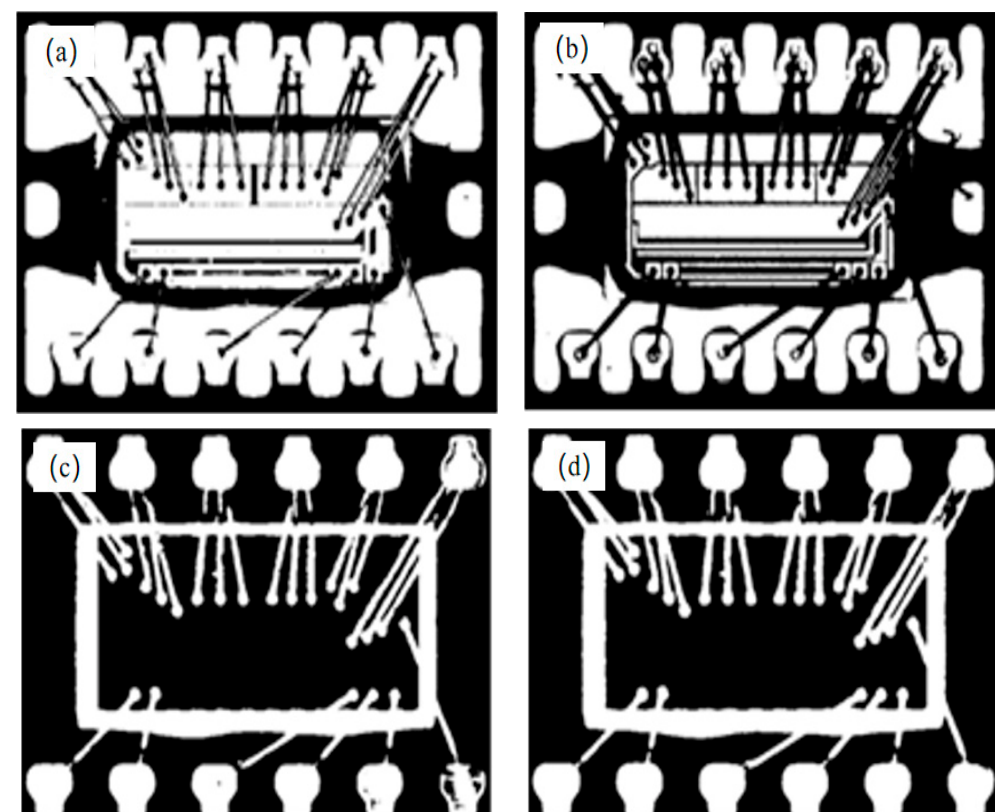
Figure 5. Comparison of thresholding segmentation effect between the classical OSTU method and the improved OSTU method for dark field images. Binary image of plastic package side obtained using ( a ) classical OSTU and ( b ) improved OSTU. Binary image of pin side obtained using ( c ) classical OSTU and ( d ) improved OSTU.